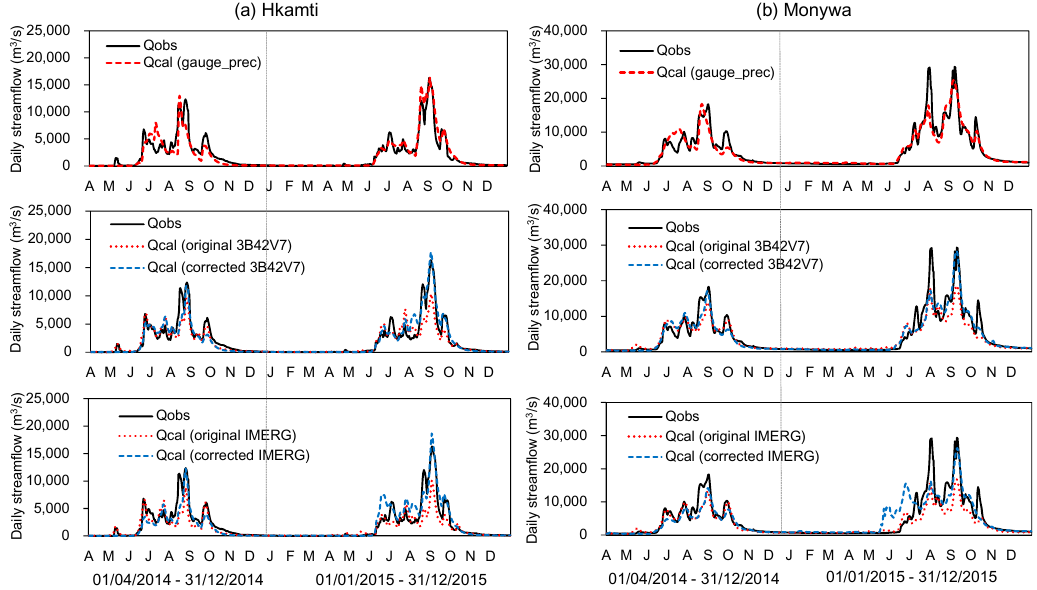
Figure 8. Simulated daily hydrographs using the gauge-based precipitation data, the original 3B42V7 and IMERG precipitation estimates, and their corrected data sets at: Hkamti ( a ); and Monywa ( b ) streamflow stations. Qobs represents the observed streamflow. Qcal (gauged prec), Qcal (original 3B42V7), Qcal (corrected 3B42V7), Qcal (original IMERG), and Qcal (corrected IMERG) represent the calculated streamflow using the gauge-based precipitation data, the original and corrected 3B42V7 data sets, and the original and corrected IMERG data sets, respectively.